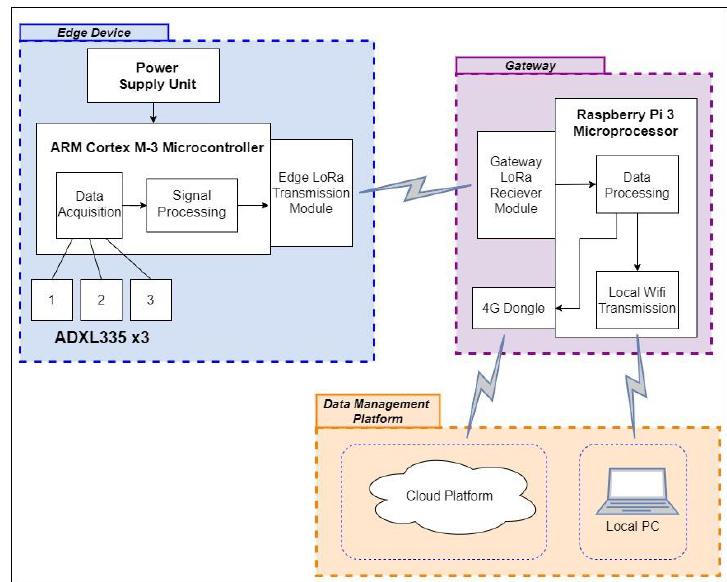
Figure 7. Low-power SHM framework.